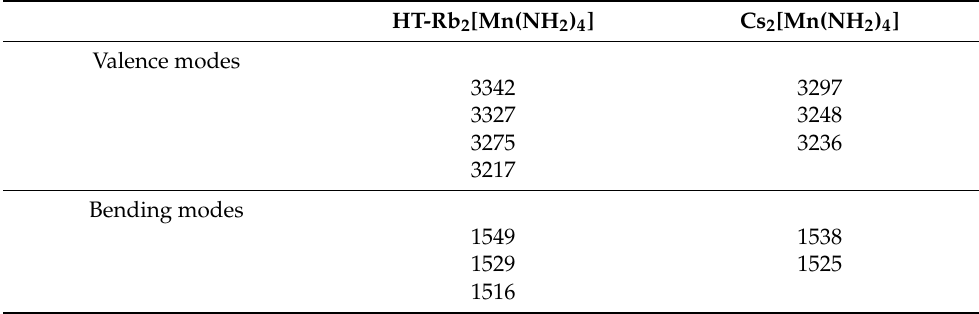
Table 4. List of observed modes in the infrared spectra of HT-Rb 2 [Mn(NH 2 ) 4 ] and Cs 2 [Mn(NH 2 ) 4 ]. All values are given in cm − 1